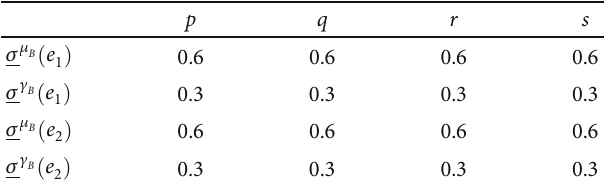
Table 31: Lower approximation of B .